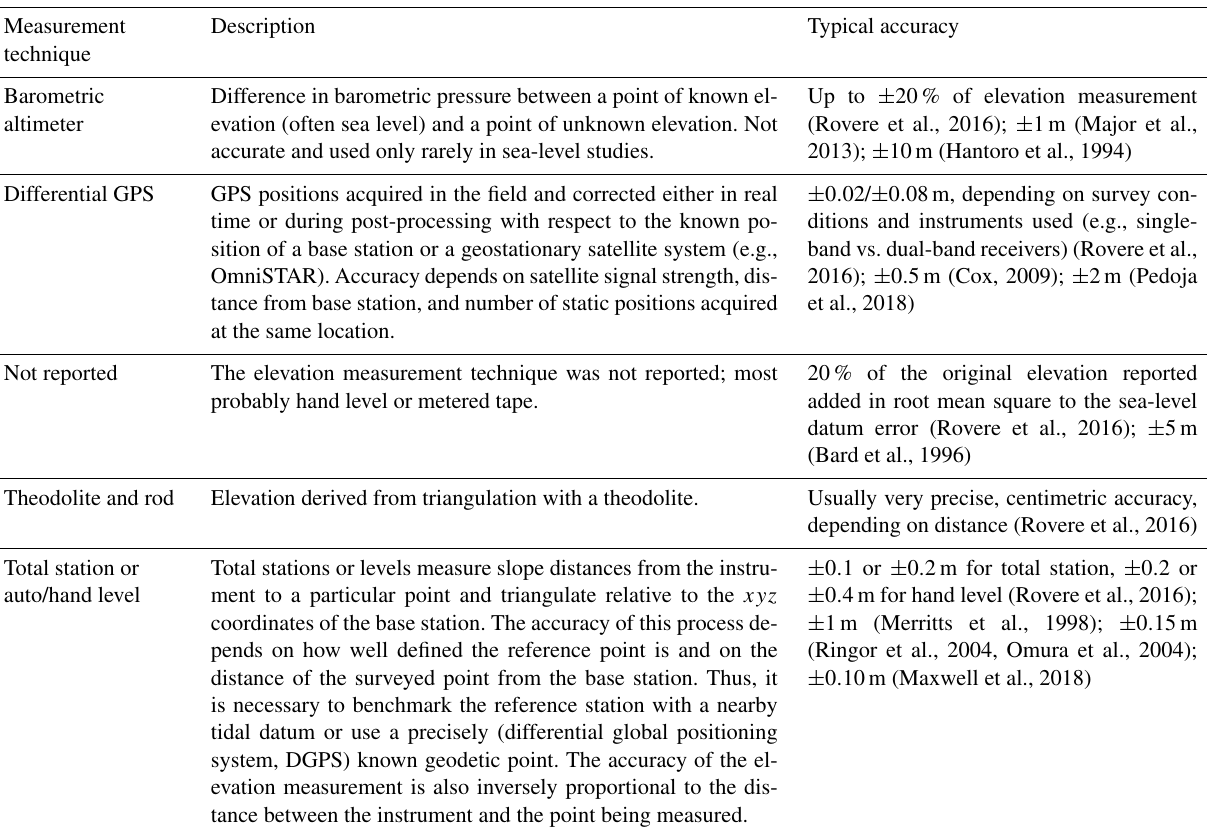
Table 2. Measurement techniques reported by the published studies and associated measurement